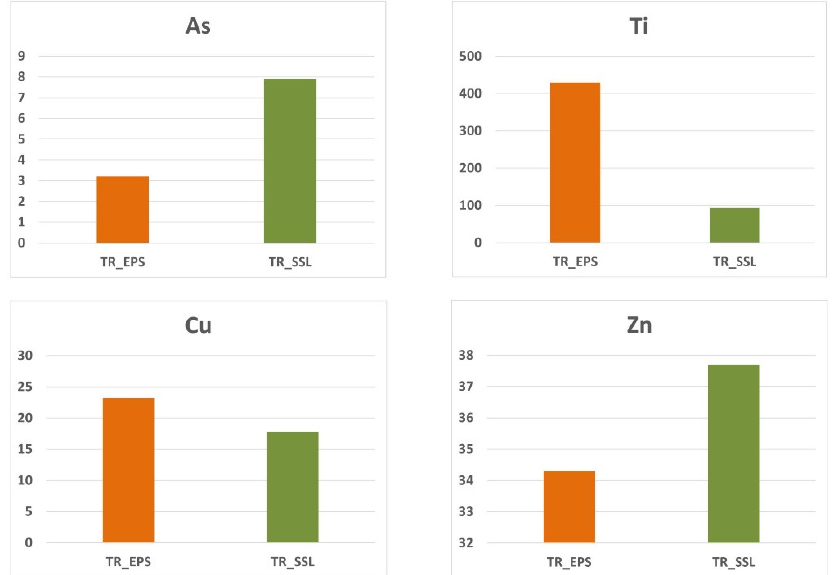
Figure 3. Bar diagrams showing the concentration of some PTEs (heavy metals expressed in ppm) in tremolite asbestos from Episcopia (TR_EPS) and San Severino Lucano (TR_SSL).